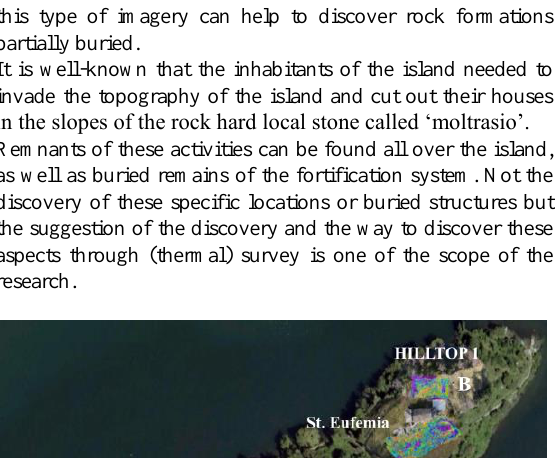
Fig. 10. Thermal and RGM orthophotos derived from rigorous UAV image triangulation (RGB+thermal - level 1 ) for the site St. Eufemia.